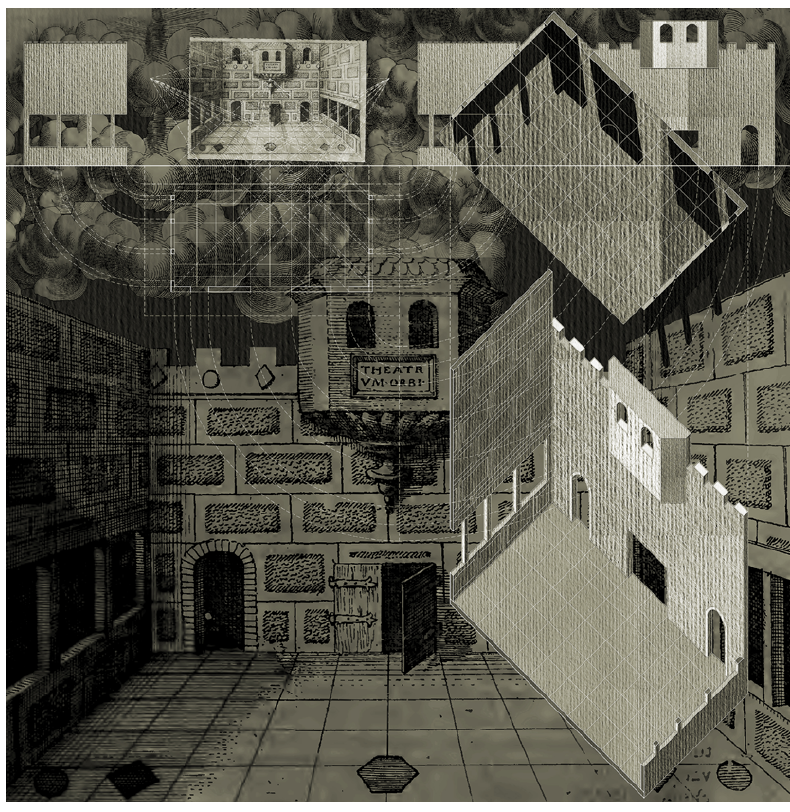
Redrawing of the Theatrum Orbi as presented in Robert Fludd, “Ars memoriae” in Utriusque Cosmi. Maioris scilicet et minoris metaphysica, physica atque tech- nica Historia (Oppenheim: Hieronymi Galleri, 1617),